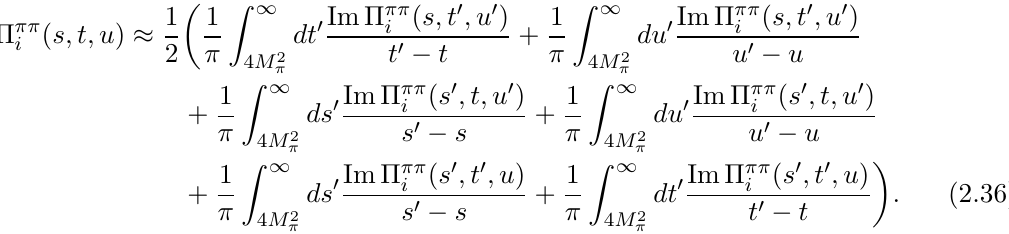
Figure 8. Mandelstam diagram for HLbL scattering for the case q 2 with all the double-spectral regions for \2disc"-box